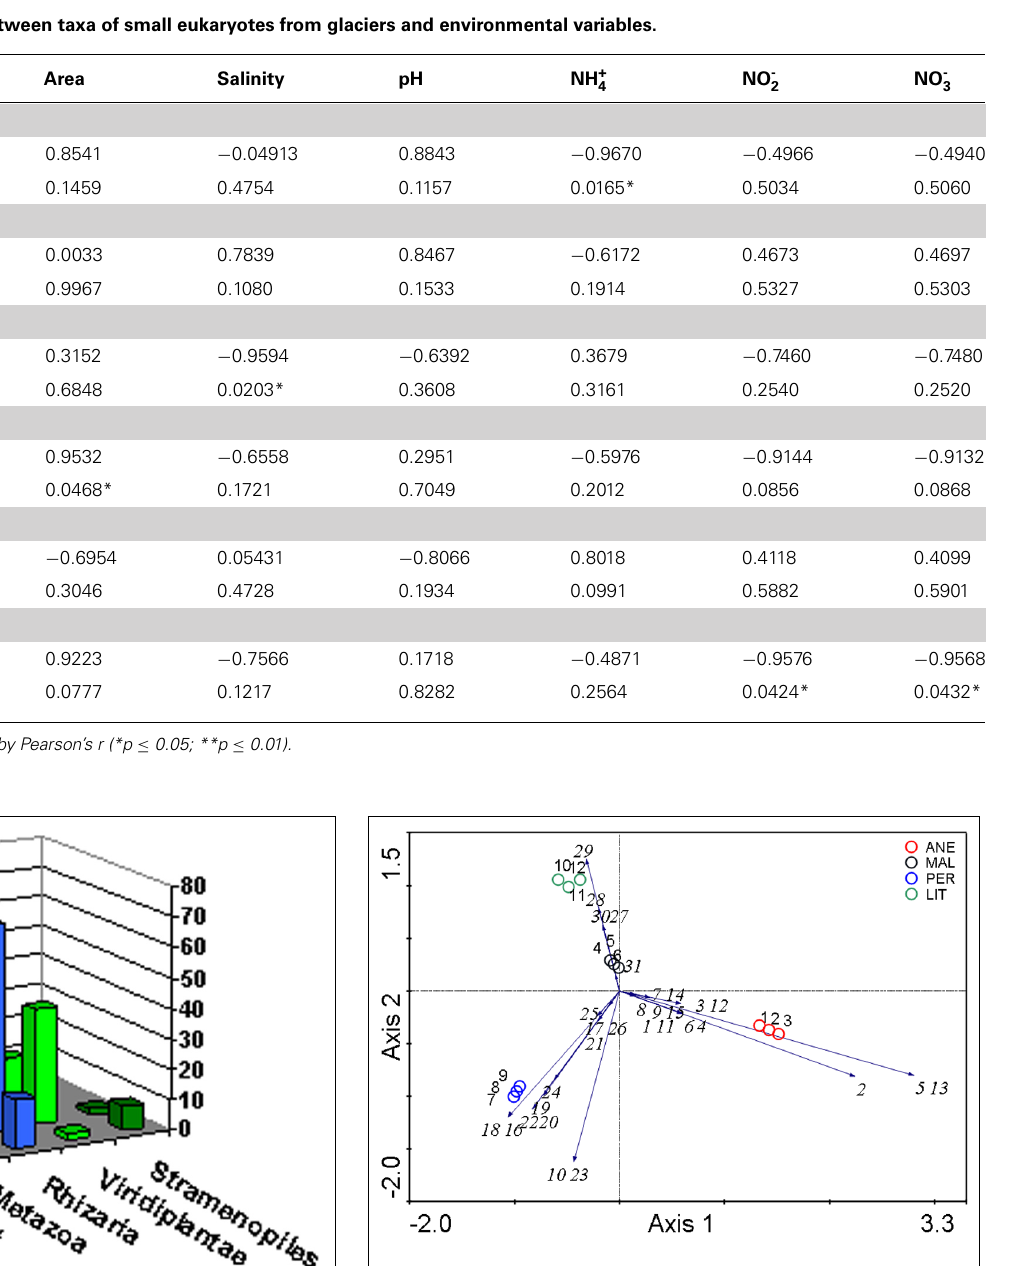
FIGURE 7 | Comparison of the microbial communities using the PCA analysis. Numbers represent phylotypes as shown in Table 2 and Figure 8 . The diagram display circles representing sampling sites and arrows that indicate the direction of increase for the